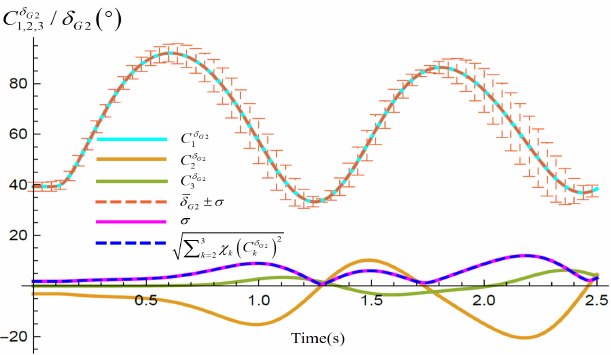
Figure 1. Trajectotires of swing angle and its coefficients in 3-generator, 9-bus system case. If uncertain parameters are not uniformly distributed, statistical quantities of y (cid:48) ( t , p (cid:48)